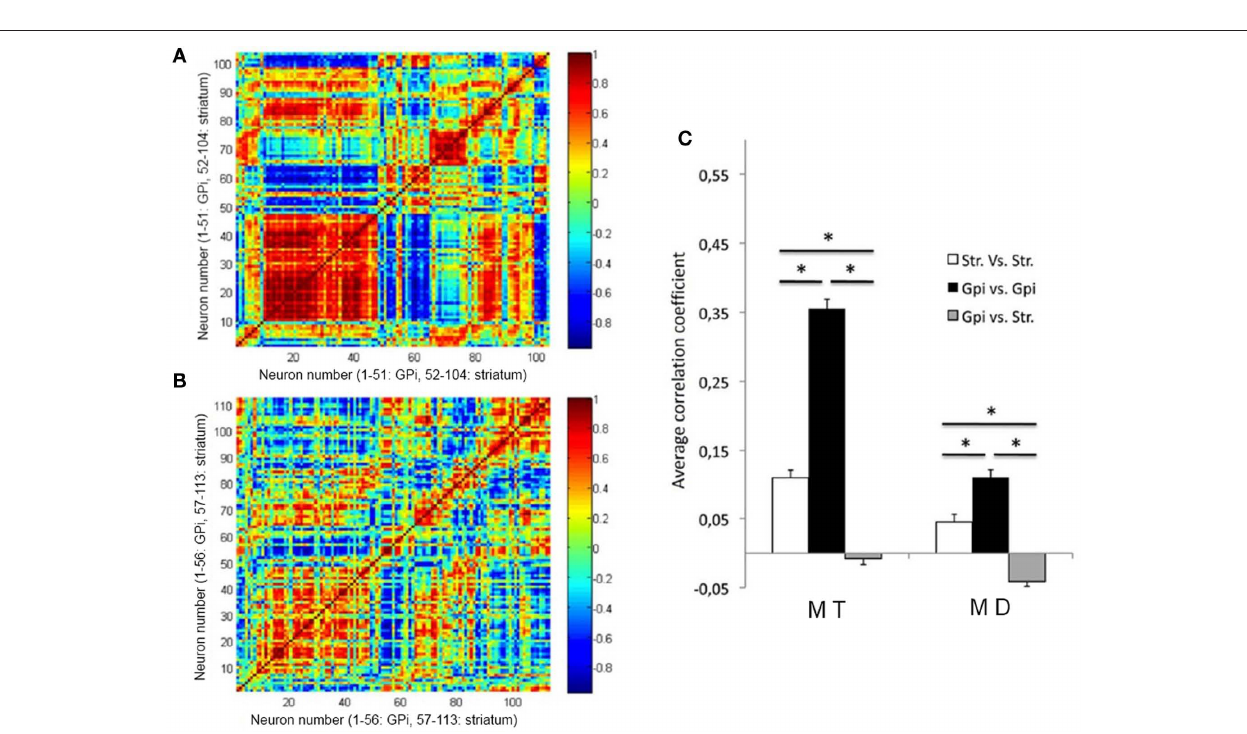
Figure 2 | NieTH plots from the striatum (left) and gPi (right) of monkey T (top) and monkey D (bottom), aligned on each event. The neurons were sorted using the curve peak time value. The color bar indicates the normalized amplitude value for each neuron.